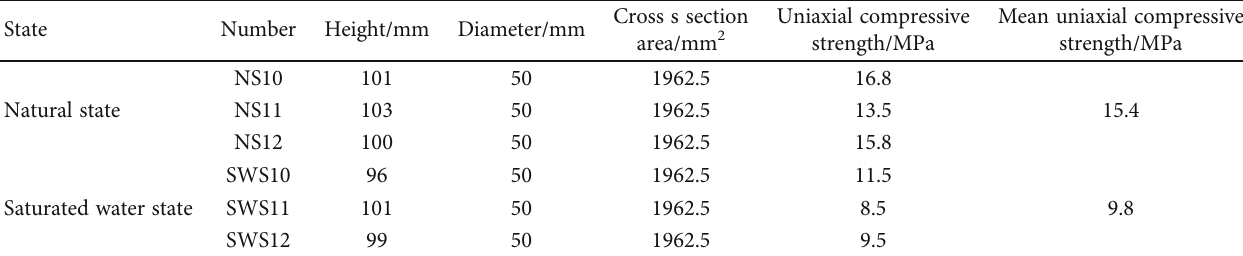
ff erent states. C ) under di